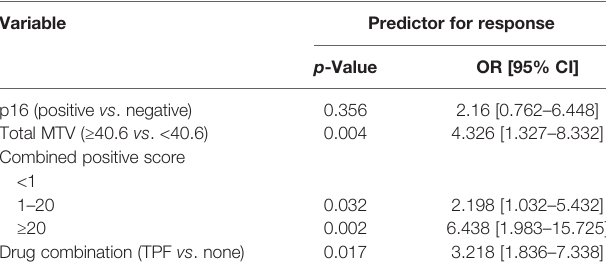
TABLE 3 | Multivariate analysis of the association between general variables and treatment response in the 105